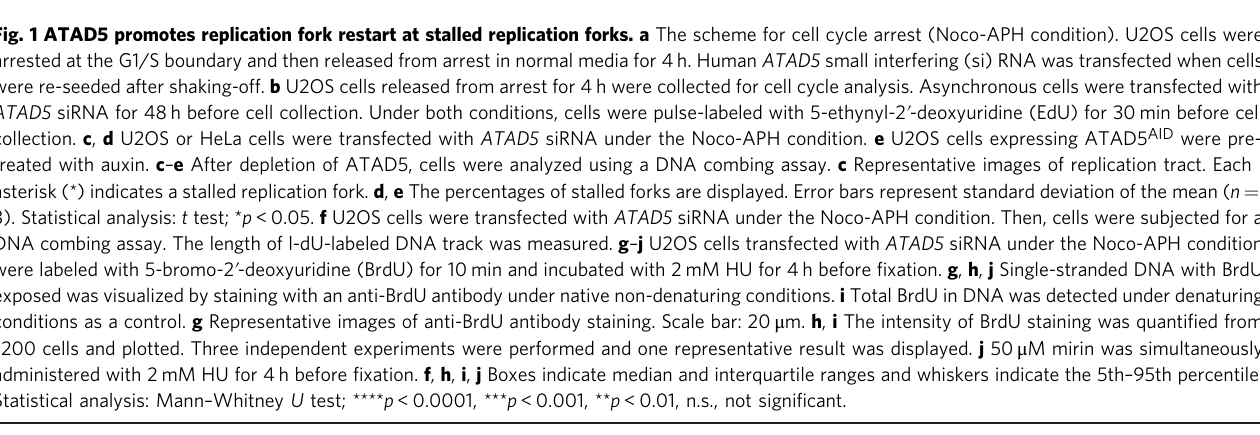
Fig. 1 ATAD5 promotes replication fork restart at stalled replication forks. a The scheme for cell cycle arrest (Noco-APH condition). U2OS cells were arrested at the G1/S boundary and then released from arrest in normal media for 4 h. Human ATAD5 small interfering (si) RNA was transfected when cells were re-seeded after shaking-off. b U2OS cells released from arrest for 4 h were collected for cell cycle analysis. Asynchronous cells were transfected with ATAD5 siRNA for 48 h before cell collection. Under both conditions, cells were pulse-labeled with 5-ethynyl-2 ʹ -deoxyuridine (EdU) for 30 min before cell collection. c , d U2OS or HeLa cells were transfected with ATAD5 siRNA under the Noco-APH condition. e U2OS cells expressing ATAD5 AID were pre- treated with auxin. c – e After depletion of ATAD5, cells were analyzed using a DNA combing assay. c Representative images of replication tract. Each asterisk (*) indicates a stalled replication fork. d , e The percentages of stalled forks are displayed. Error bars represent standard deviation of the mean ( n = 3). Statistical analysis: t test; * p < 0.05. f U2OS cells were transfected with ATAD5 siRNA under the Noco-APH condition. Then, cells were subjected for a DNA combing assay. The length of l-dU-labeled DNA track was measured. g – j U2OS cells transfected with ATAD5 siRNA under the Noco-APH condition were labeled with 5-bromo-2 ʹ -deoxyuridine (BrdU) for 10 min and incubated with 2 mM HU for 4 h before fi xation. g , h , j Single-stranded DNA with BrdU exposed was visualized by staining with an anti-BrdU antibody under native non-denaturing conditions. i Total BrdU in DNA was detected under denaturing conditions as a control. g Representative images of anti-BrdU antibody staining. Scale bar: 20 μ m. h , i The intensity of BrdU staining was quanti fi ed from ~200 cells and plotted. Three independent experiments were performed and one representative result was displayed. j 50 μ M mirin was simultaneously administered with 2 mM HU for 4 h before fi xation. f , h , i , j Boxes indicate median and interquartile ranges and whiskers indicate the 5th – 95th